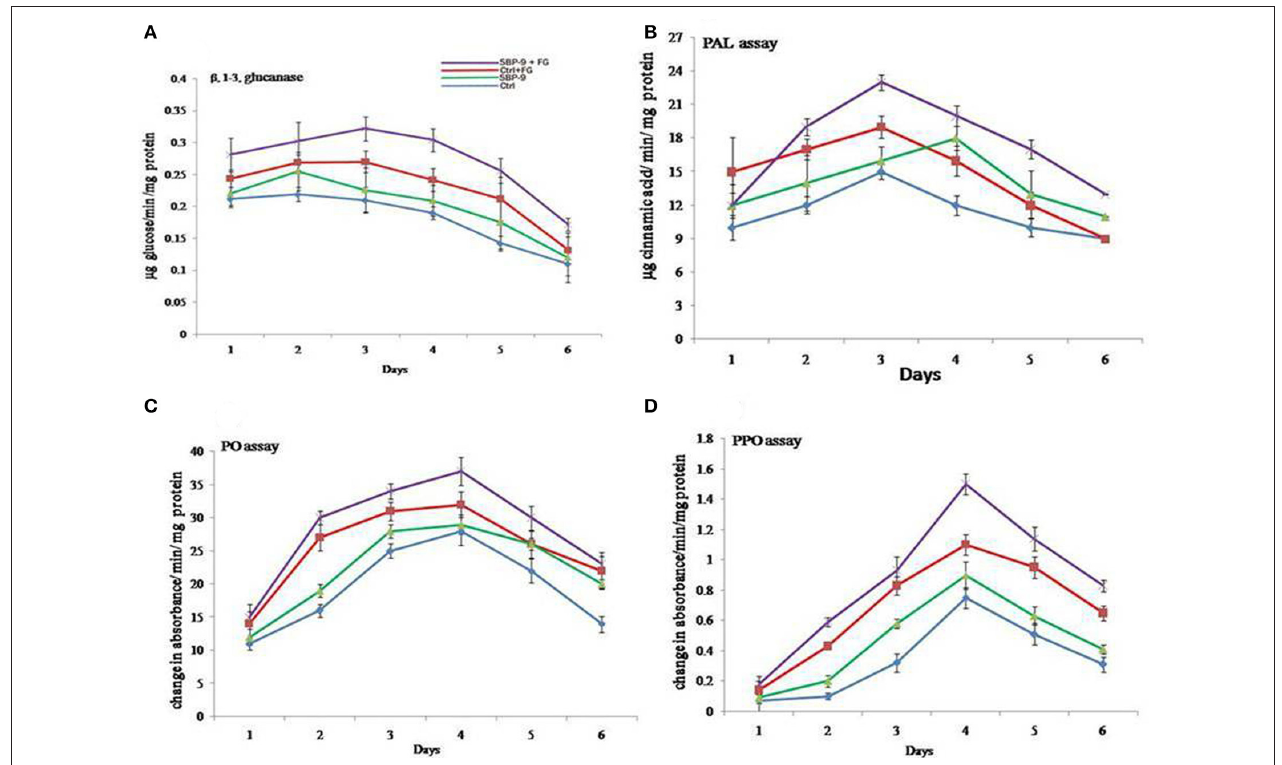
FIGURE 7 | Augmentation of defense response in wheat by S. maltophila SBP-9 against Fusarium graminearum under controlled conditions; (A) β 1, 3-glucanase assay (B) Phenylalanine ammonia lyase assay (C) Peroxidase assay (D) Polyphenol oxidase